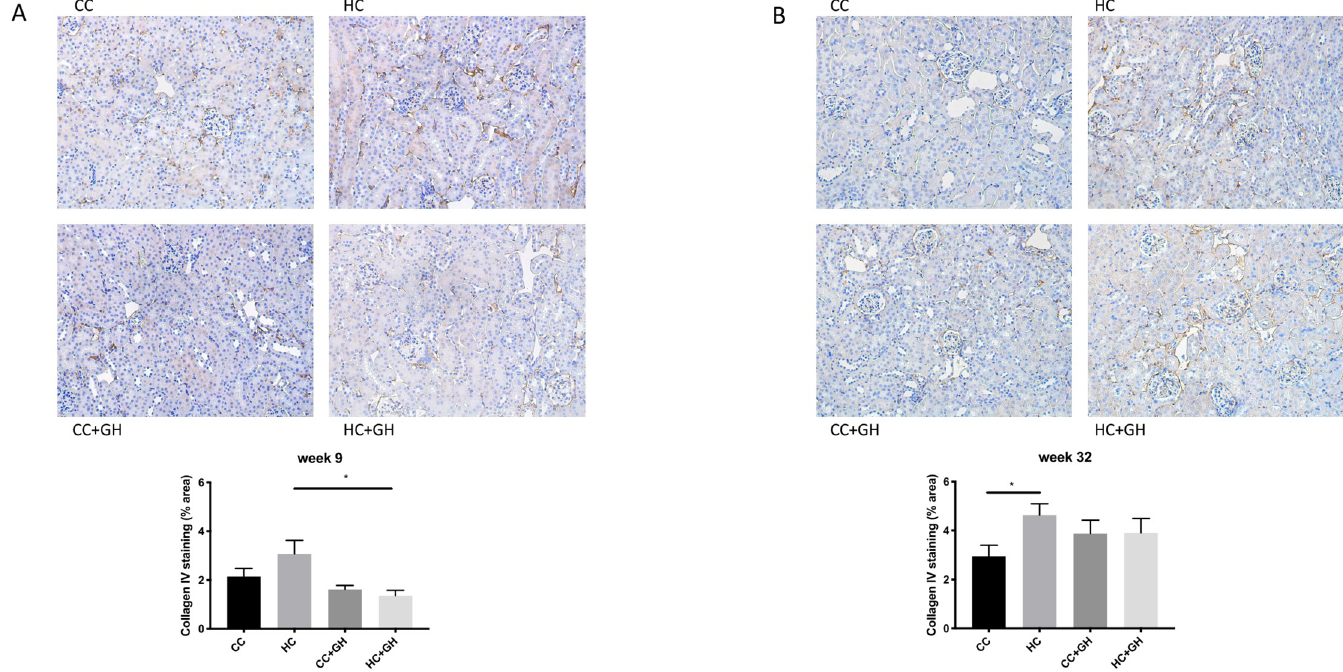
Fig 9. Renal fibrotic changes as measured by collagen IV immunohistochemistry. (A) Week 9 offspring representative images of collagen IV staining at 200x magnification, and quantitation (B) week 32 offspring representative images of collagen IV staining at 200x magnification, and quantitation. Results expressed as mean ± SEM, n = 6. � p <